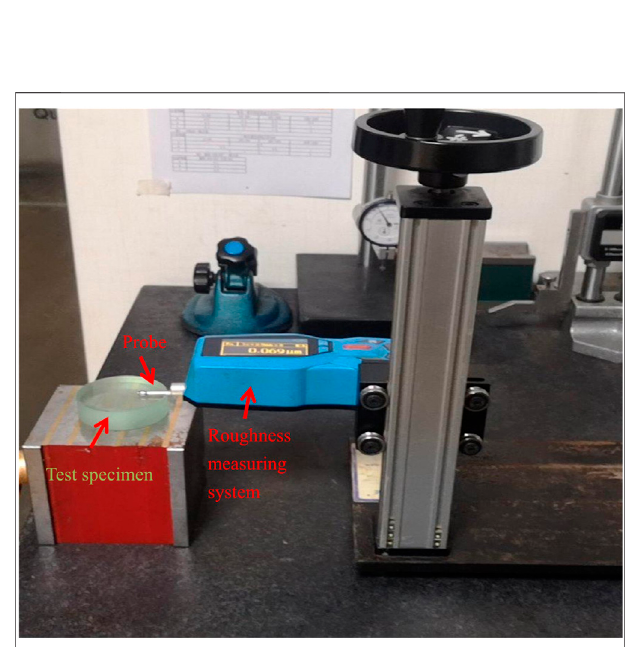
FIGURE 2 | The surface roughness-measuring instrument used in the tests.